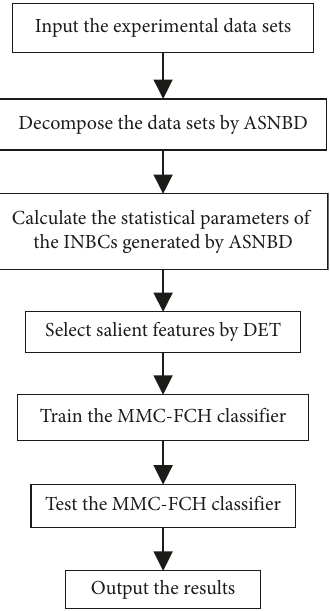
Figure 10: The flow chart of the method proposed in section 5.1.